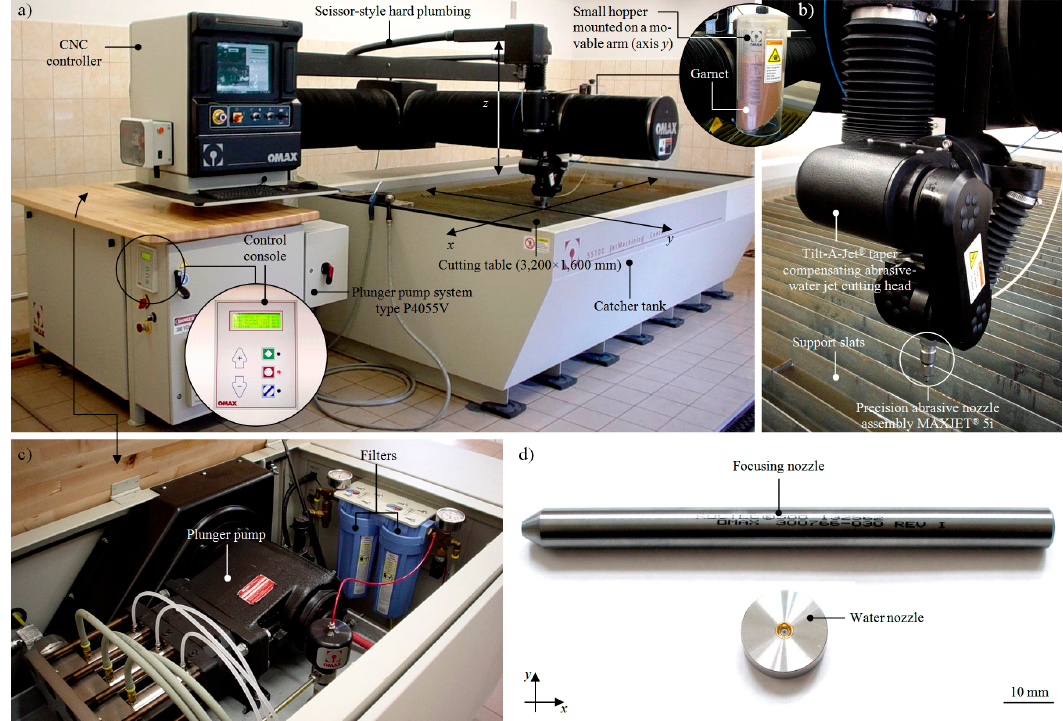
Figure 4. Precision AWJ system used during experimental studies—JetMachining ® Center type 55100 (OMAX Corp., Kent, WA, USA): ( a ) general view of the center with main components; ( b ) close-up on the Tilt-A-Jet ® cutting head (OMAX Corp., Kent, WA, USA) and abrasive nozzle assembly MAXJET ® 5; ( c ) close-up on the plunger pump and filters; ( d ) two type of nozzles used in the cutting head.